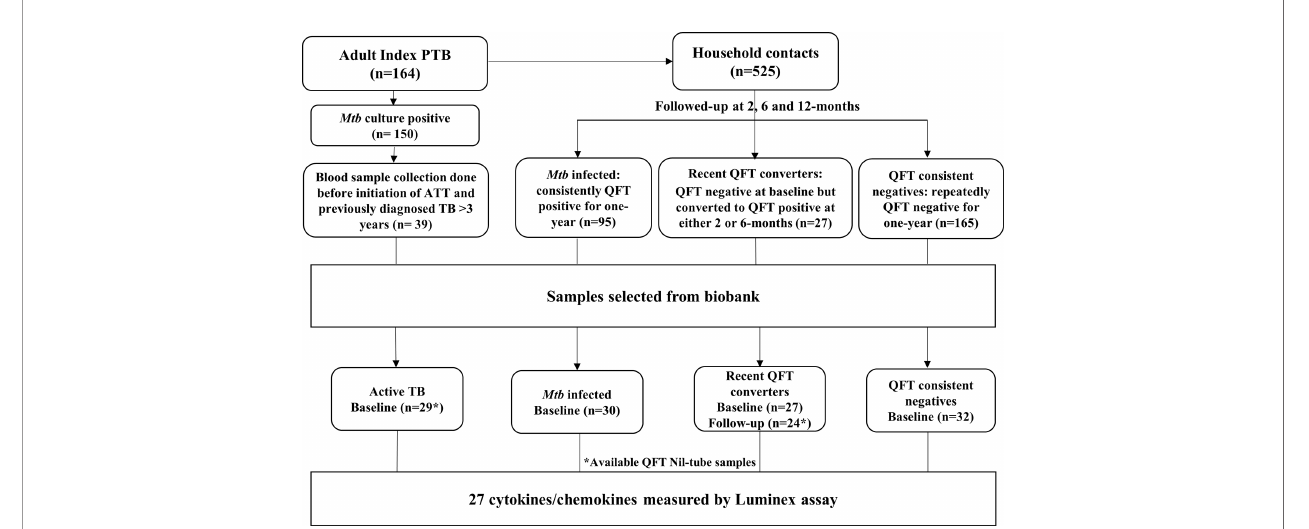
FIGURE 1 | Study fl ow